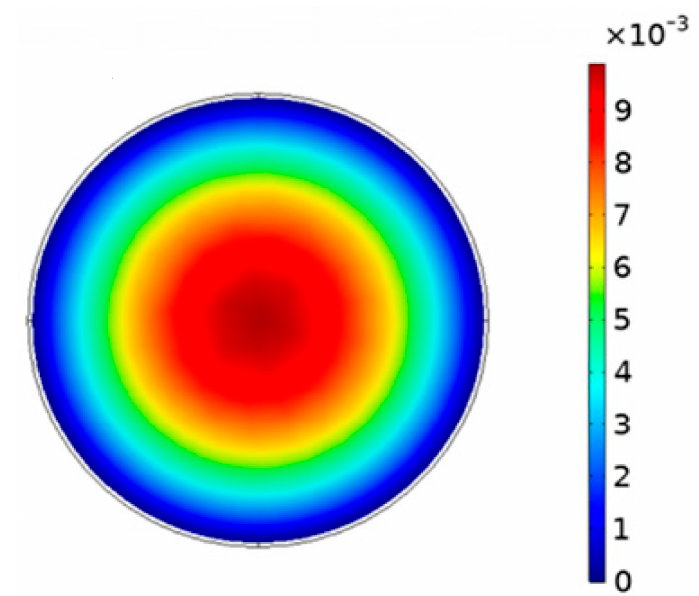
Figure 12. The flow velocity of the radial